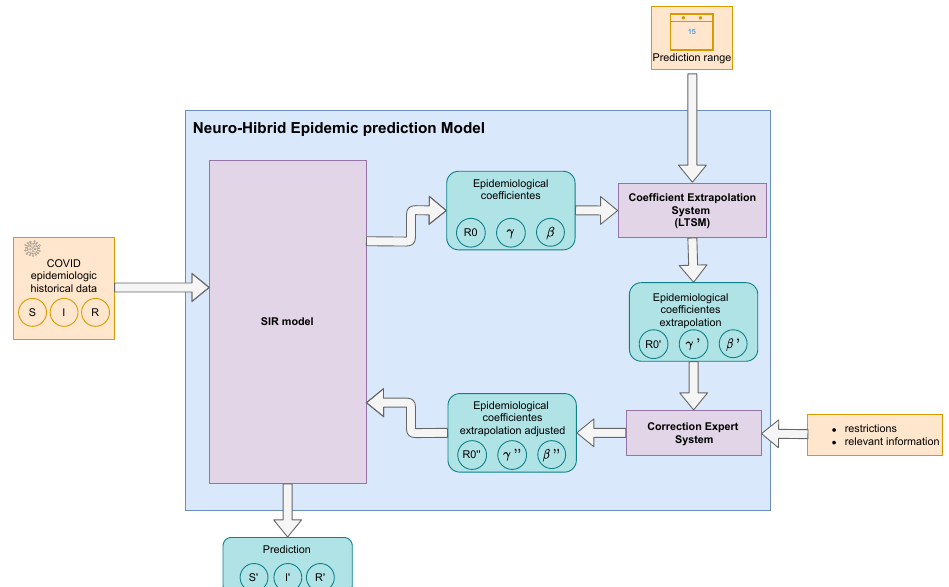
Figure 1. A historical dataset is used to calculate how COVID-19 evolves over a certain period of time and the curves S (the time-dependent susceptible population), I (the time-dependent infected population) and R (the time-dependent removed (recovered, death) population) are extracted over this period of time. These variables are used to fit an SIR model using sliding windows. The dif- ferential equations are solved using a Runge–Kutta method and the fit is performed in the sense of mean squares, thus extracting the unknown parameters of the model: β and γ , as well as the basic reproductive number R 0 , all of them being functions of time. To extrapolate these parameters to higher time values ( β (cid:48) , γ (cid:48) , R (cid:48) ), an LSTM neural network is used, the results of which are further 0 refined by using an expert system that takes into account possible future changes in the constraints imposed by the government ( β (cid:48)(cid:48) , γ (cid:48)(cid:48) , R (cid:48)(cid:48) in the diagram). Finally, by solving the SIR model again with 0 these extrapolated coefficients, the predictions in the evolution of the S (cid:48) , I (cid:48) and R (cid:48) curves are